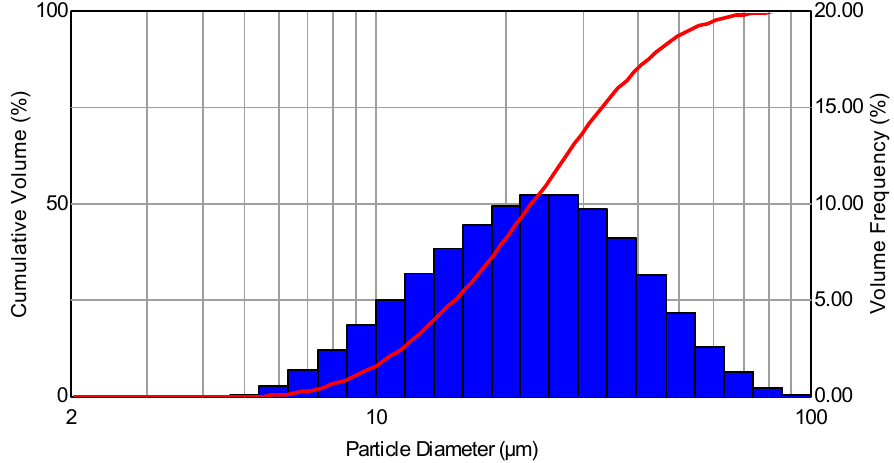
Figure 1. The distribution of droplet sizes generated by the Lumina ST-6R1.3 nozzle.